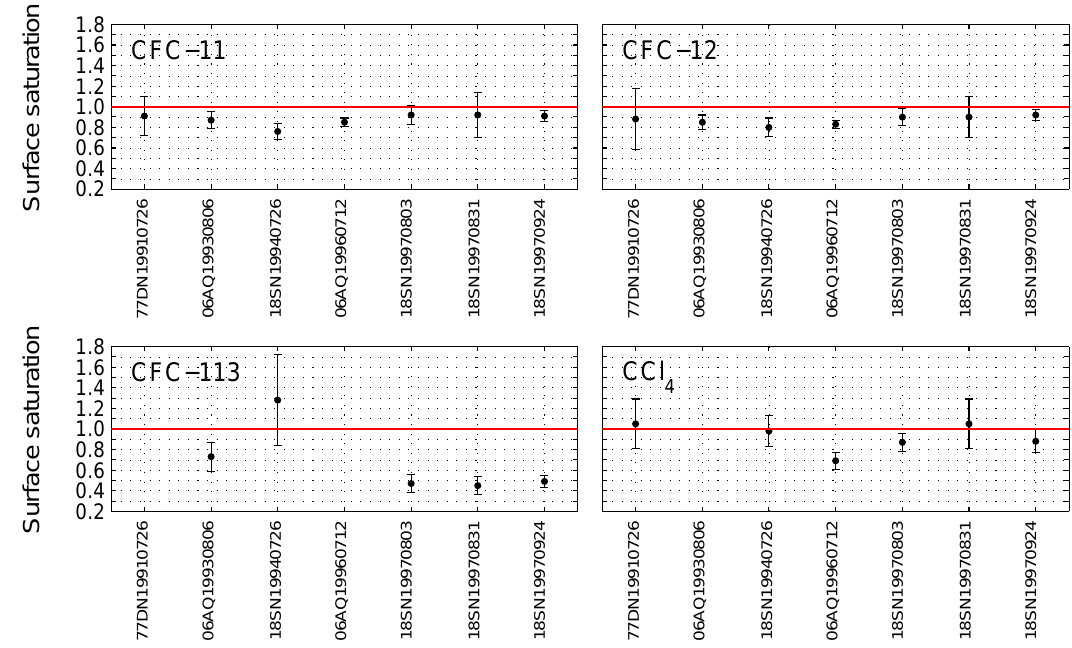
Figure 18. Surface saturations (upper 20dbars) of the CFCs in the Arctic Ocean cruises of CARINA. The error bars show the standard deviations. The cruises are sorted chronologically in order to see any trends in the